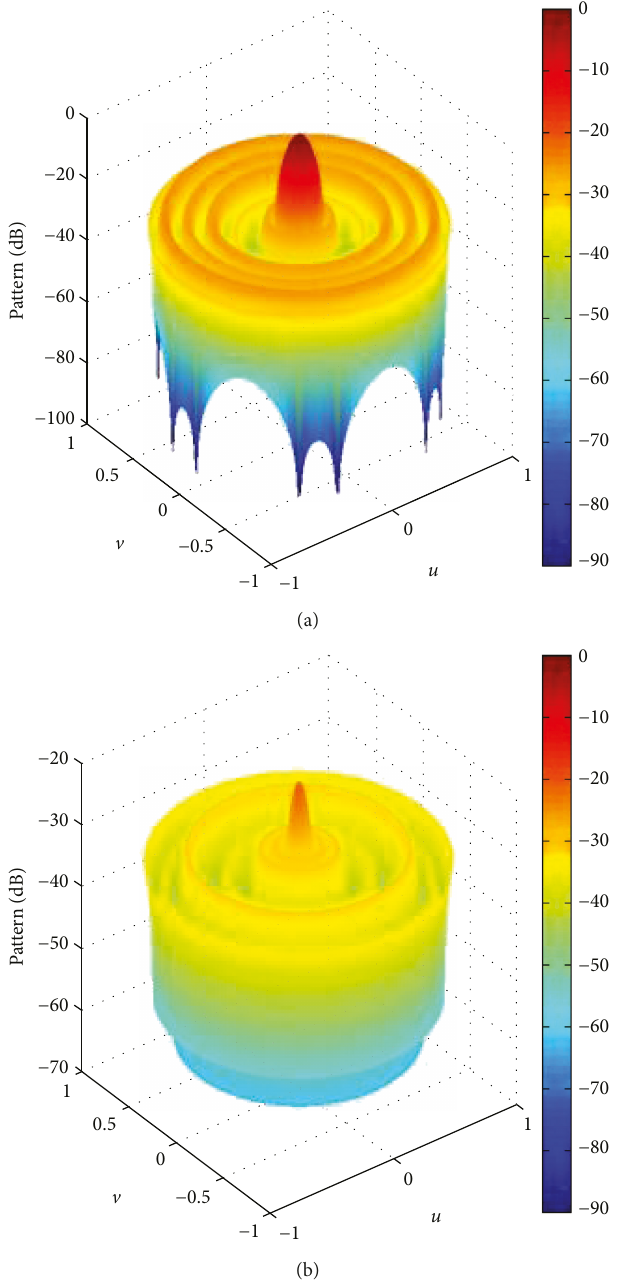
Figure 4: Radiation patterns for individual C 1 : (a) at the center frequency ( s =0) and (b) at the fi rst sideband ( s